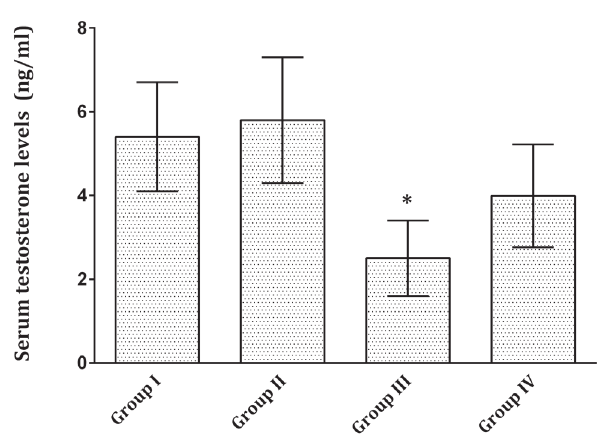
FIGURE 1 - Serum testosterone levels obtained from rats from different experimental groups. Data are shown as mean ± SD (n=6). *p<0.001 vs. Control (group